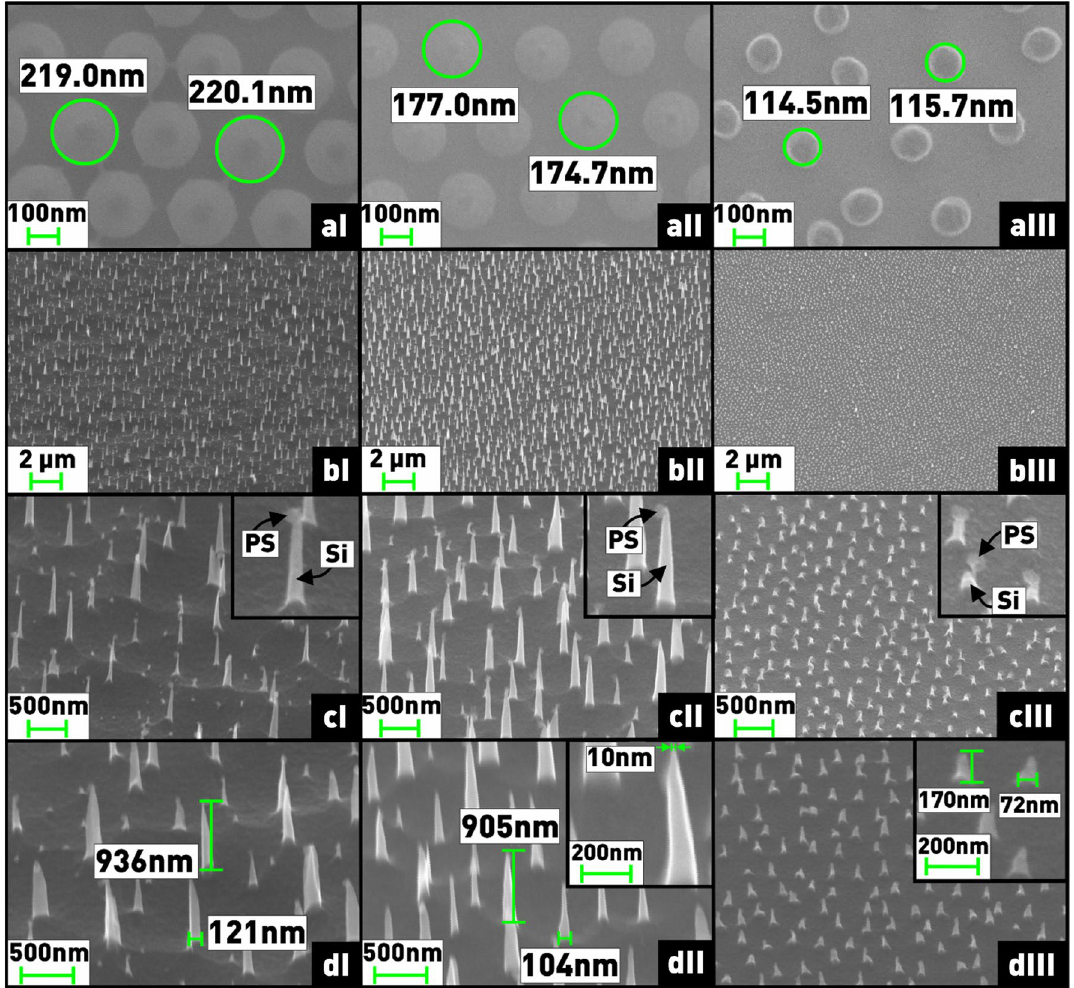
Figure 14. (a) Microphotographs of nanosphere masks with different size of nanospheres; (b,c) microphotographs of nanoneedle arrays after Si etching in SF 6 /C 4 F 8 plasma; (d) microphotographs of nanoneedle arrays after removal of nanospheres in O 2 plasma. Microphotographs taken at angle of